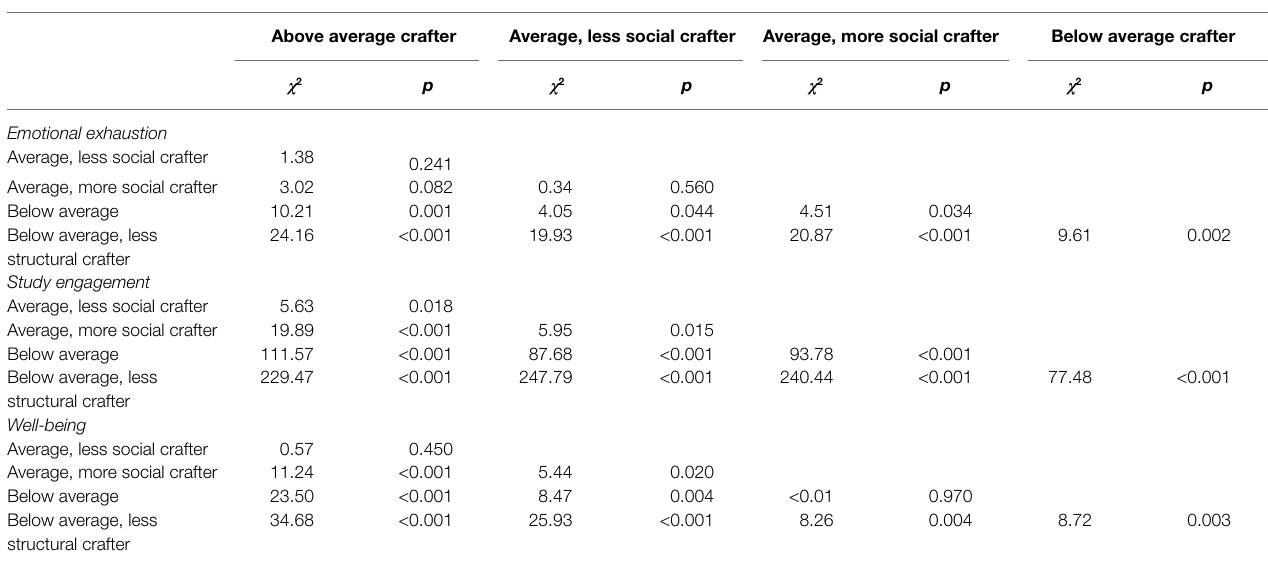
TABLE 5 | Wald tests ( N = 2,822). Above average crafter Average, less social crafter Average, more social crafter Below average crafter